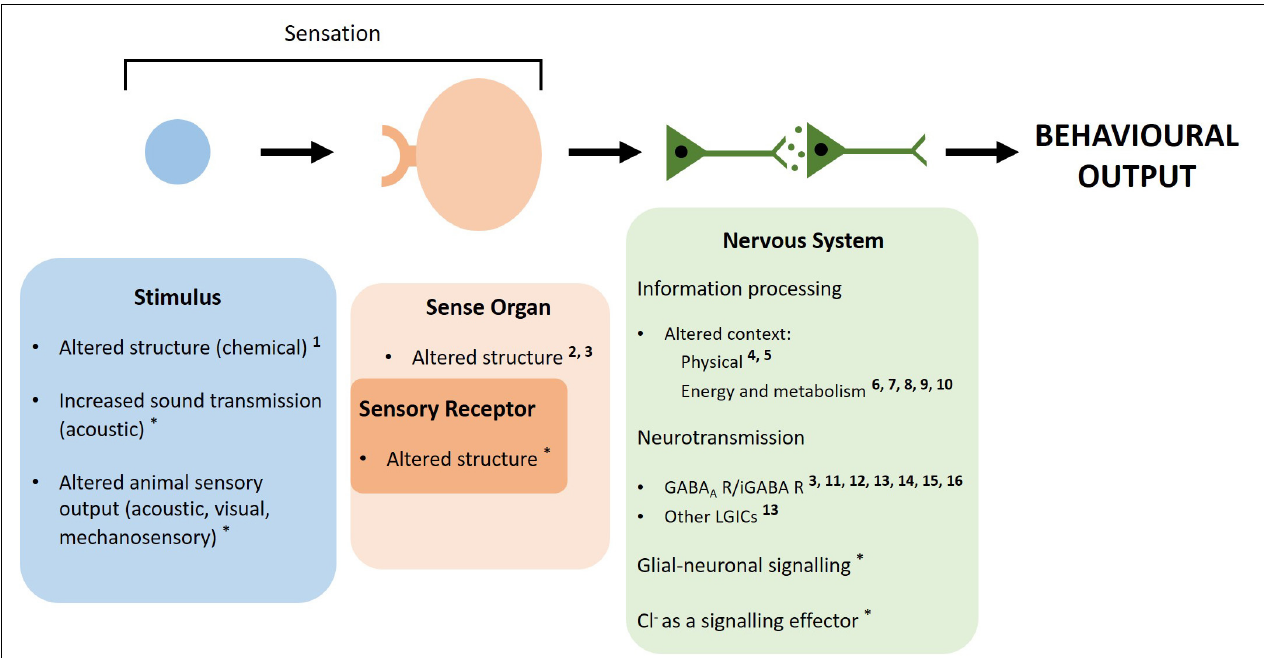
FIGURE 1 | Simplistic pathway of how the nervous system produces behaviors and potential ways elevated CO 2 could alter marine invertebrate behavior. An external or internal stimulus is detected by sensory receptors located on a sense organ. A physical stimulus binding to a receptor, e.g., a chemical cue binding to the corresponding receptor (chemoreception), is depicted. However, stimuli and receptors may range from photoreceptors detecting light energy to stretch receptors detecting body movement or hair cells detecting vibrations. The detected sensory information is then transduced into electrical impulses that are relayed between neurons to higher centers of the nervous system. Here, the information is processed which includes using external and internal contextual factors to make behavioral choices. The information is transmitted between neurons to the motor system and a behavioral response is produced. Throughout this process, neurotransmission is used to relay the electrical impulses from neuron to neuron. Elevated CO 2 may alter behavior by interfering at multiple points along this pathway. Sensation may be disrupted by changes to sensory stimuli at elevated CO 2 through structural change of chemical cues, increased sound transmission and altered sensory output from animals. Sensation may also be disrupted on the receiving end via altered structure of sensory receptors or physical change to sensory organs. Elevated CO 2 may change the context within which decision-making is carried out, thus influencing behavioral choices. The change in ion gradients across neuronal membranes, due to acid–base regulation at elevated CO 2 , may disrupt LGIC-mediated neurotransmission, glial-neuronal signaling and the role of Cl − as a signaling effector. Numbers represent references providing evidence for each mechanism in marine invertebrates, while a * indicates this mechanism is based on theory with no experimental evidence in marine invertebrates. 1 Roggatz et al. (2016), 2 Maneja et al. (2011), 3 de la Haye et al. (2012), 4 Bibby et al. (2007), 5 Chan et al. (2011), 6 Dissanayake and Ishimatsu (2011), 7 Li and Gao (2012), 8 Peng et al. (2017), 9 Wang et al. (2018), 10 (Rich et al., 2018), 11 Watson et al. (2014), 12 Charpentier and